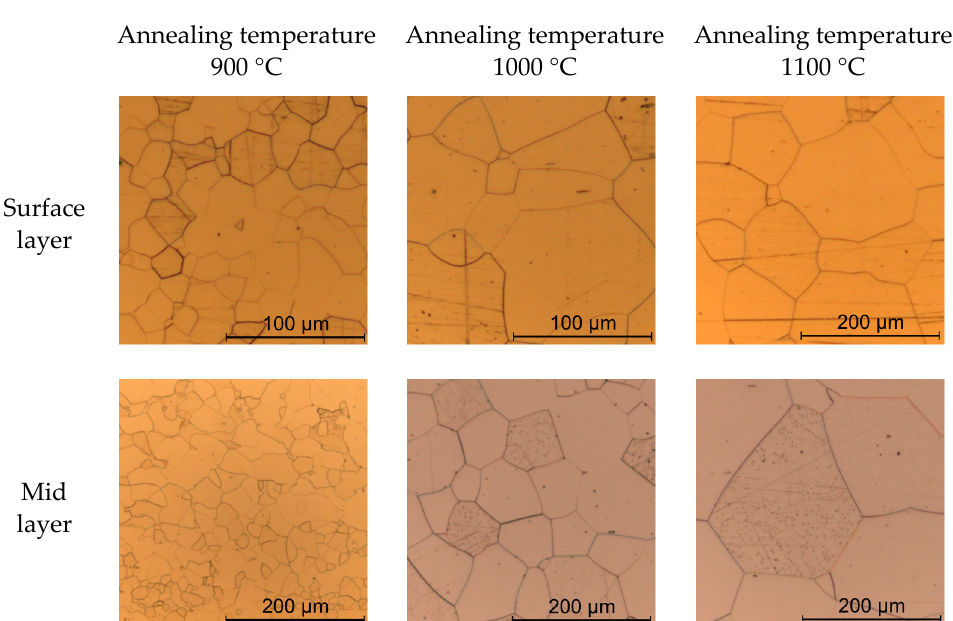
Figure 1. Microstructure images of steel sheets with 0.5 mm sheet thickness.